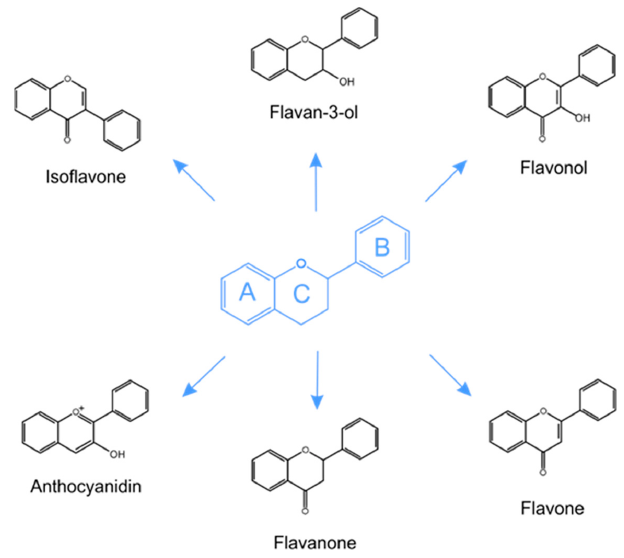
Figure 1. Generic structure of major flavonoids.